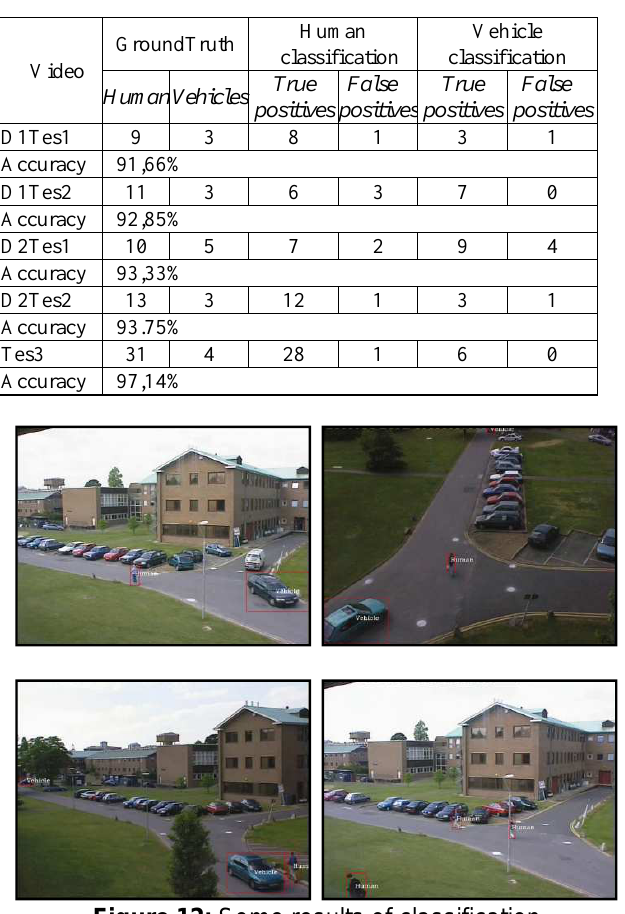
Figure 12: Some results of